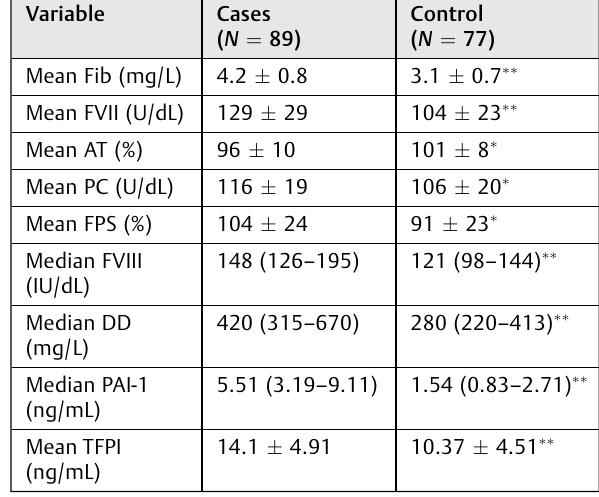
Table 2 General Hemostatic markers for the study population Table 1 Anthropometric and metabolic parameters for the